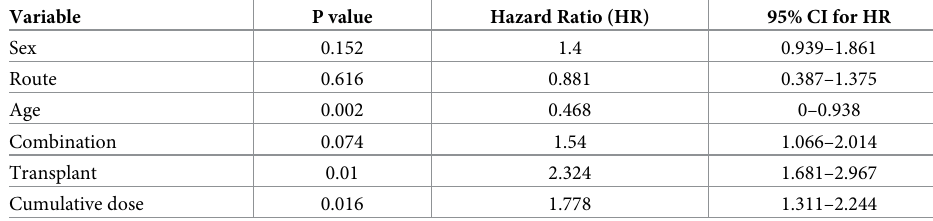
Table 5. Univariate cox regression analysis for RMM cohort.